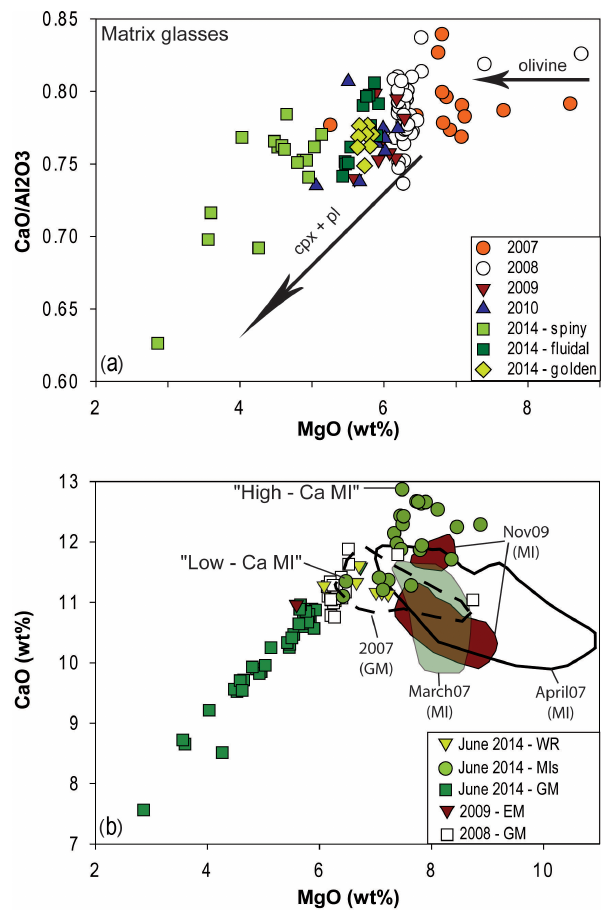
Figure 8. (a) Evolution of CaO / Al 2 O 3 ratio in the matrix glasses of recent eruptions at Piton de la Fournaise as a function of MgO content (directly proportional to melt temperature). MI is the melt inclusions (grey area for the 2014 samples). (b) CaO versus MgO content for Piton de la Fournaise products. WR: whole rock; GM: ground mass; MI: melt inclusion; EM: embayment glass.